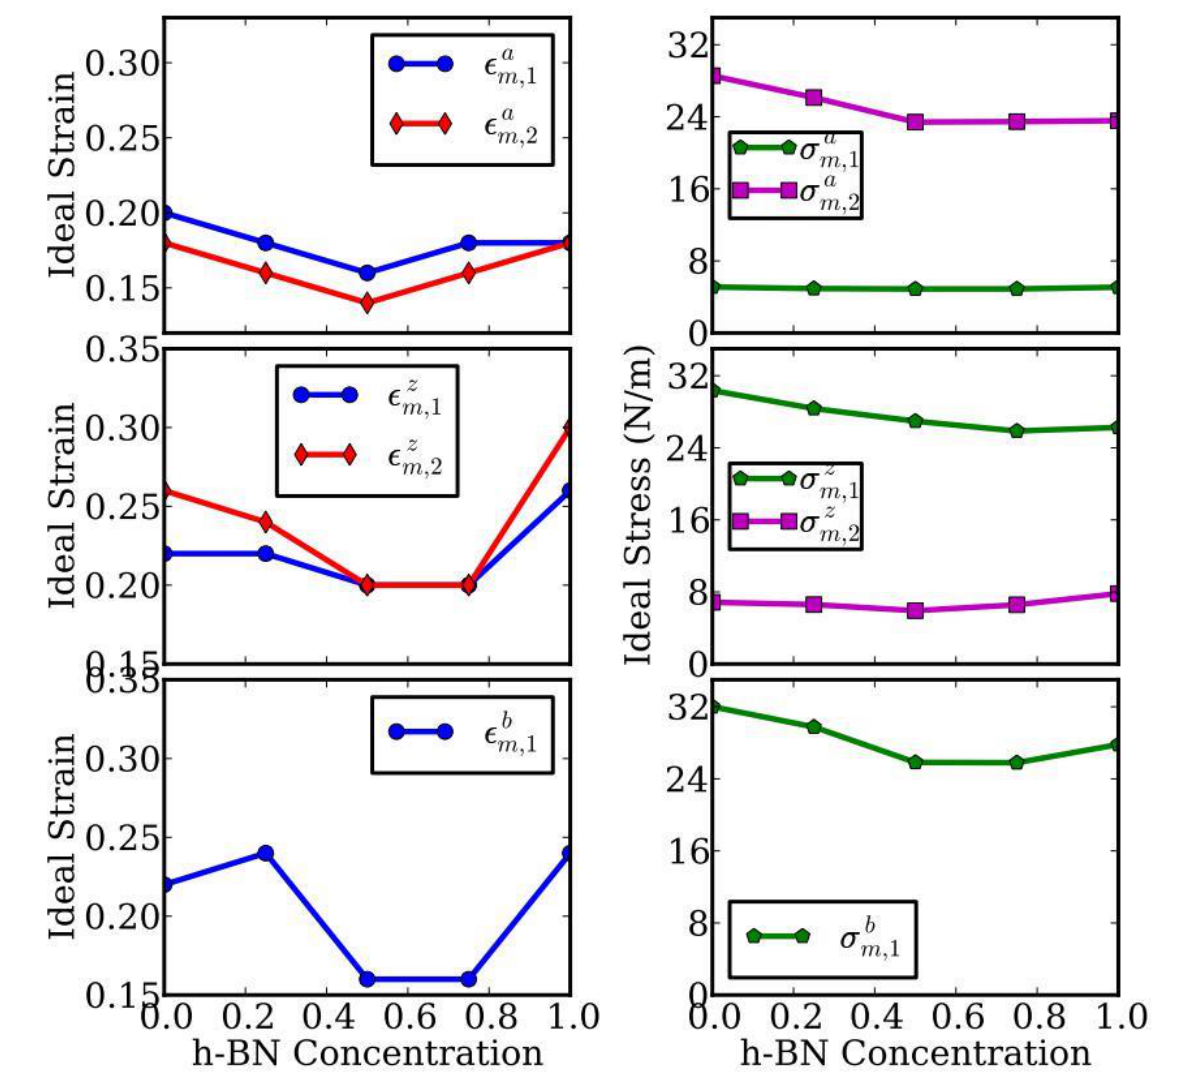
Figure 5. The ideal stress (ultimate stress) as well as the corresponding ideal (ultimate) strain at three deformation modes (armchair, zigzag, and equibiaxial) and two components (1 and 2) as a function of g -BN concentrations C